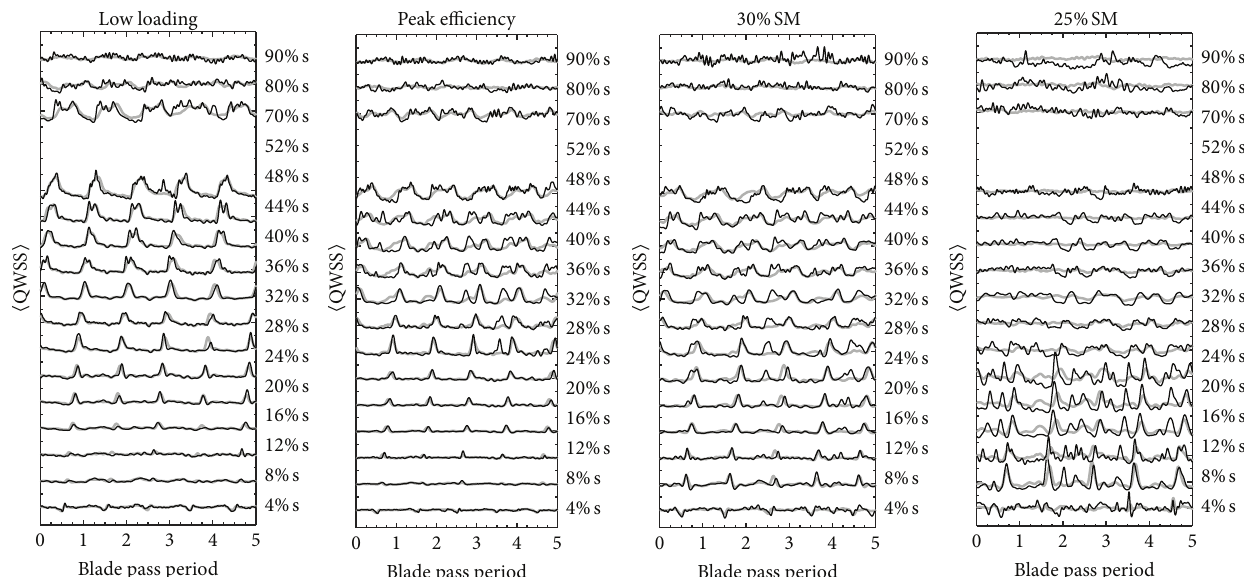
Figure 3: Raw (black) and ensemble-averaged (gray) QWSS for Stator 2 at four loading conditions.